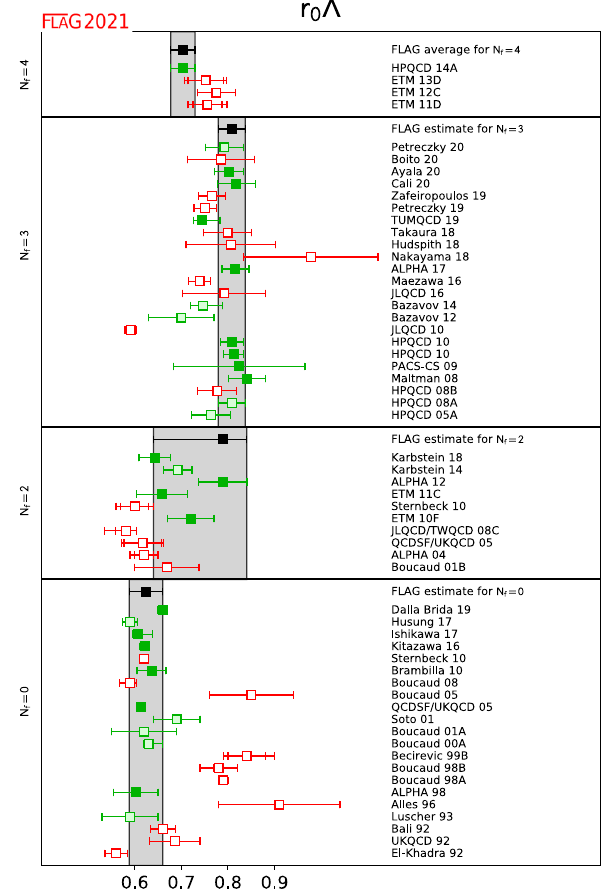
Fig. 40 r 0 (cid:8) estimates for N f = 0, 2, 3, 4 flavours. Full green squares are used in our final ranges, pale green squares also indicate that there MS are no red squares in the colour coding but the computations were superseded by later more complete ones or not published, while red open squares mean that there is at least one red square in the colour